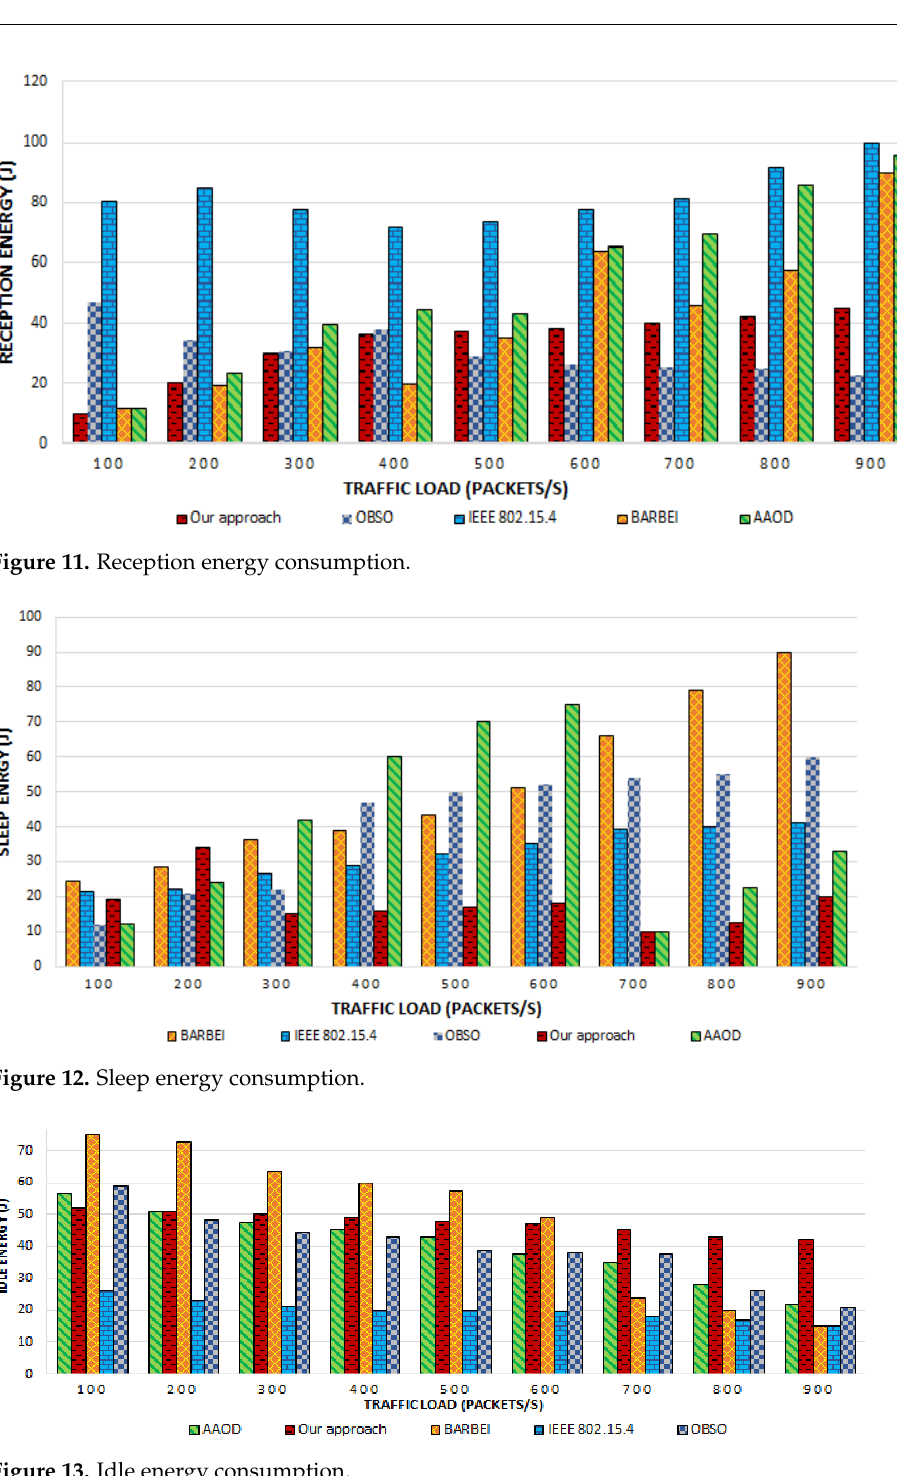
Figure 13. Idle energy consumption.